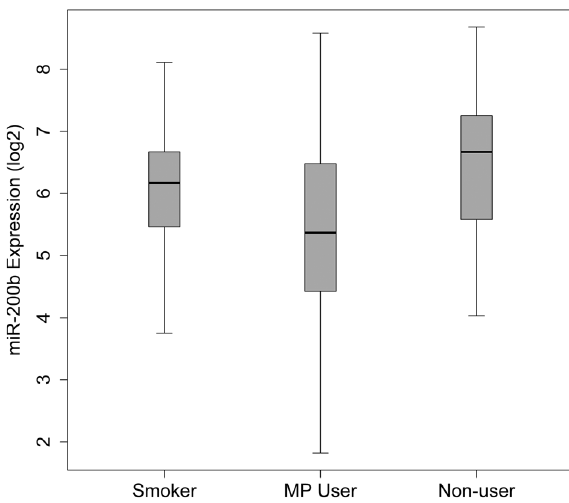
Figure 3- Boxplot of One-way Anova results for miR-200b